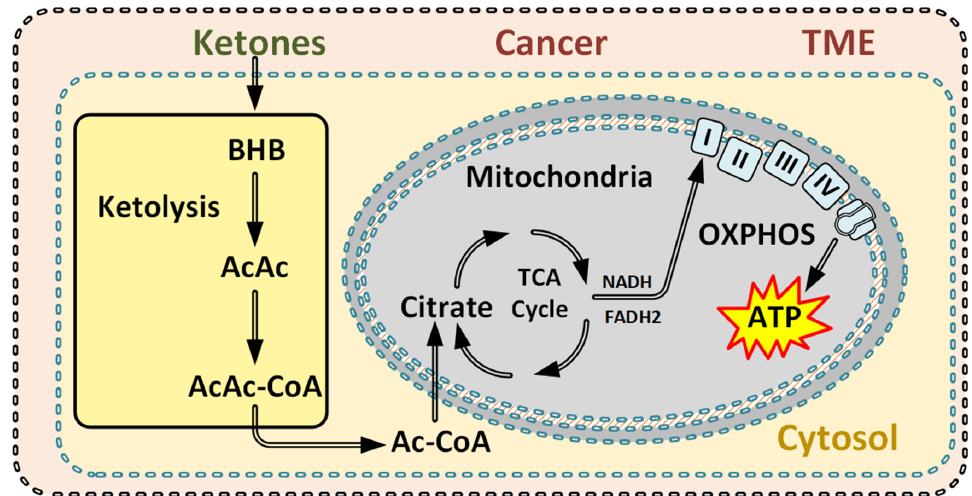
Figure 7. When ketone levels increase in the blood, the gluconeogenesis in the liver is reduced [85,86]. Ketolysis can occur in almost all healthy cells [39,82]. Ketones enter Krebs cycle through acetyl-CoA requiring oxaloacetate to enter [39,82]. Comparably, ketolysis is a short and straight pathway, and do not contribute to the production of anti-oxidative power or metabolites in cancer cells as glycolysis or glutaminolysis do (compare Figure